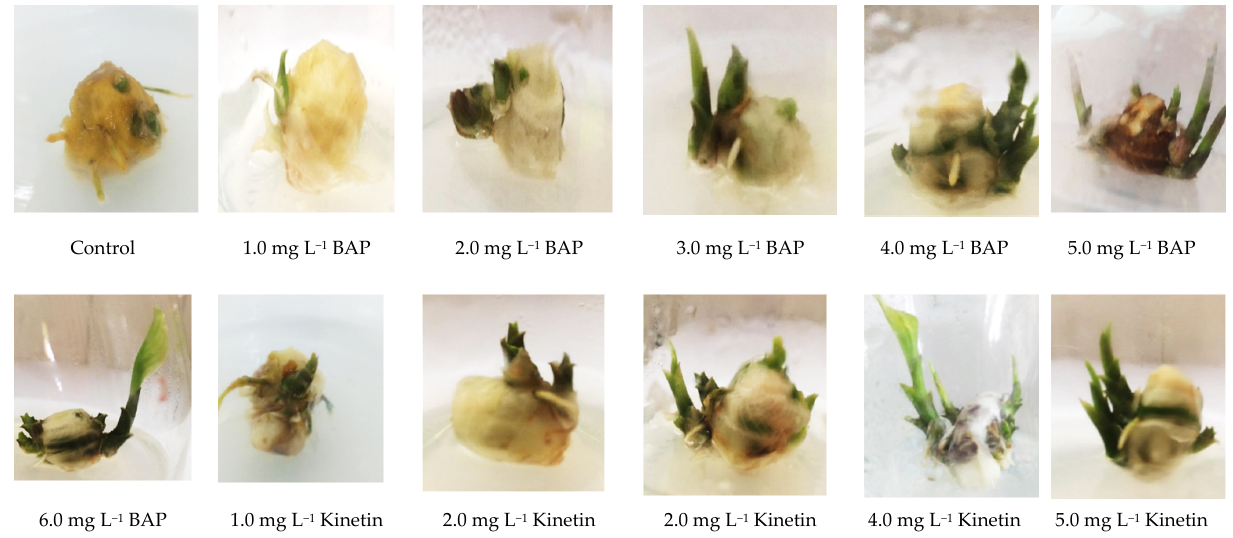
Figure 1. Evaluating the effect of BAP and kinetin on shoot regeneration of S. thorelii Gagnep. The shoot growth factor increased as BAP and kinetin concentrations were increased from 0.0 to 6.0 mg L − 1 and 0.0 to 5.0 mg L − 1 , respectively. The rate of shoot prolifera- tion tended to decline when BAP and kinetin concentrations were increased to 6.0 and 5.0 mg L − 1 , respectively. The maximum shoot growth coefficients, 5.55 ± 0.59 shoots/explants for BAP and 5.48 ± 0.87 shoots/explants for kinetin, were produced by the formulations of 5.0 mg L − 1 BAP and 4.0 mg L − 1 kinetin. Numerous studies on the cultivation of plants belonging to the Zingiberaceae family (turmeric, galangal) have shown that the use of